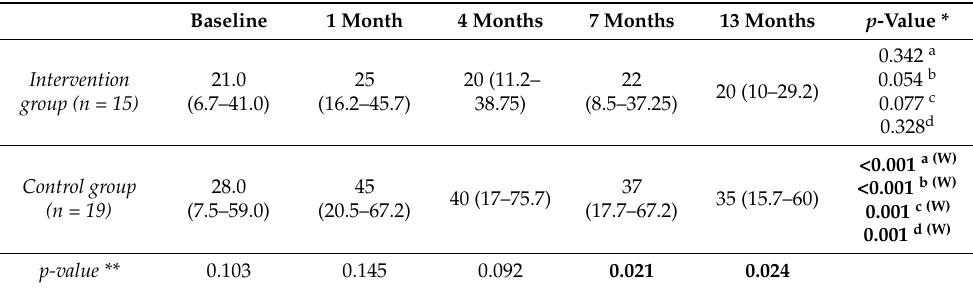
Table 4. 0–100 VAS in the two groups at different time points (Median, IQR).